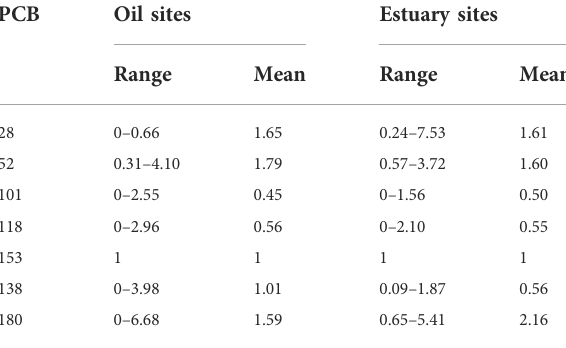
TABLE 6 Concentrations proportions of the seven congeners normalized to congener